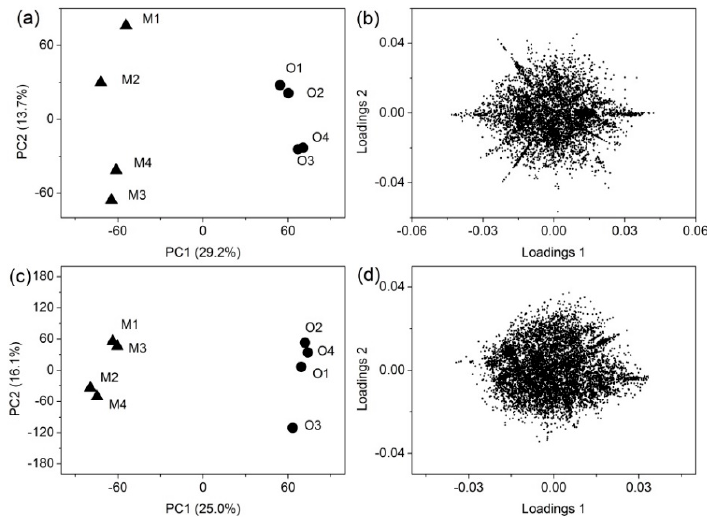
Figure 2. PCA of the metabolite features detected in the blueberry wines by different sample extraction method (SPE and SPME) followed by GC-QTOF-MS. The explained variances are shown in brackets. ( a ) Score plot of SPE; ( b ) Loading plot of SPE; ( c ) Score plot of SPME; ( d ) Loading plot of SPME. The PCA showing that the volatile metabolites are clearly different between Misty blueberry wine (M1, M2, M3, M4) and O’Neal blueberry wine OBW (O1, O2, O3, O4) despite of the extraction methods.